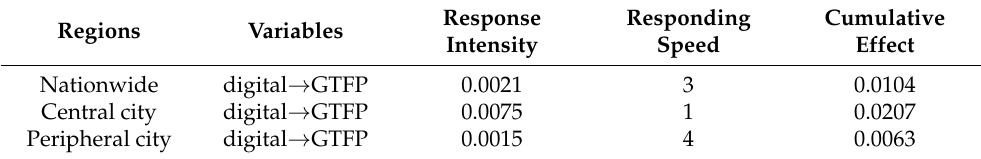
Table 4. Impulse response estimation results.